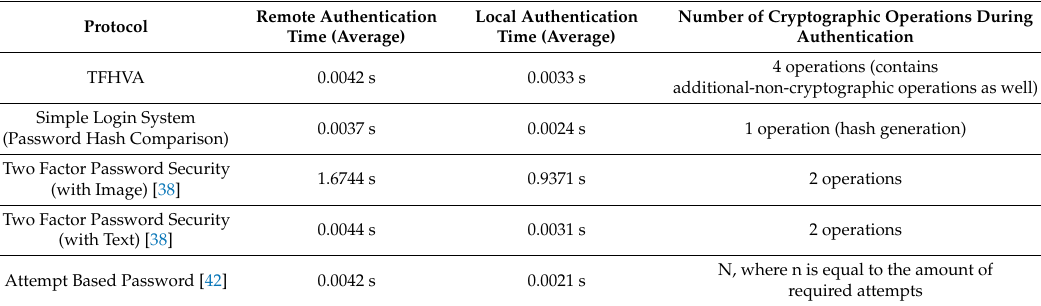
Table 5. Communication times; times averaged across 15 attempts for each